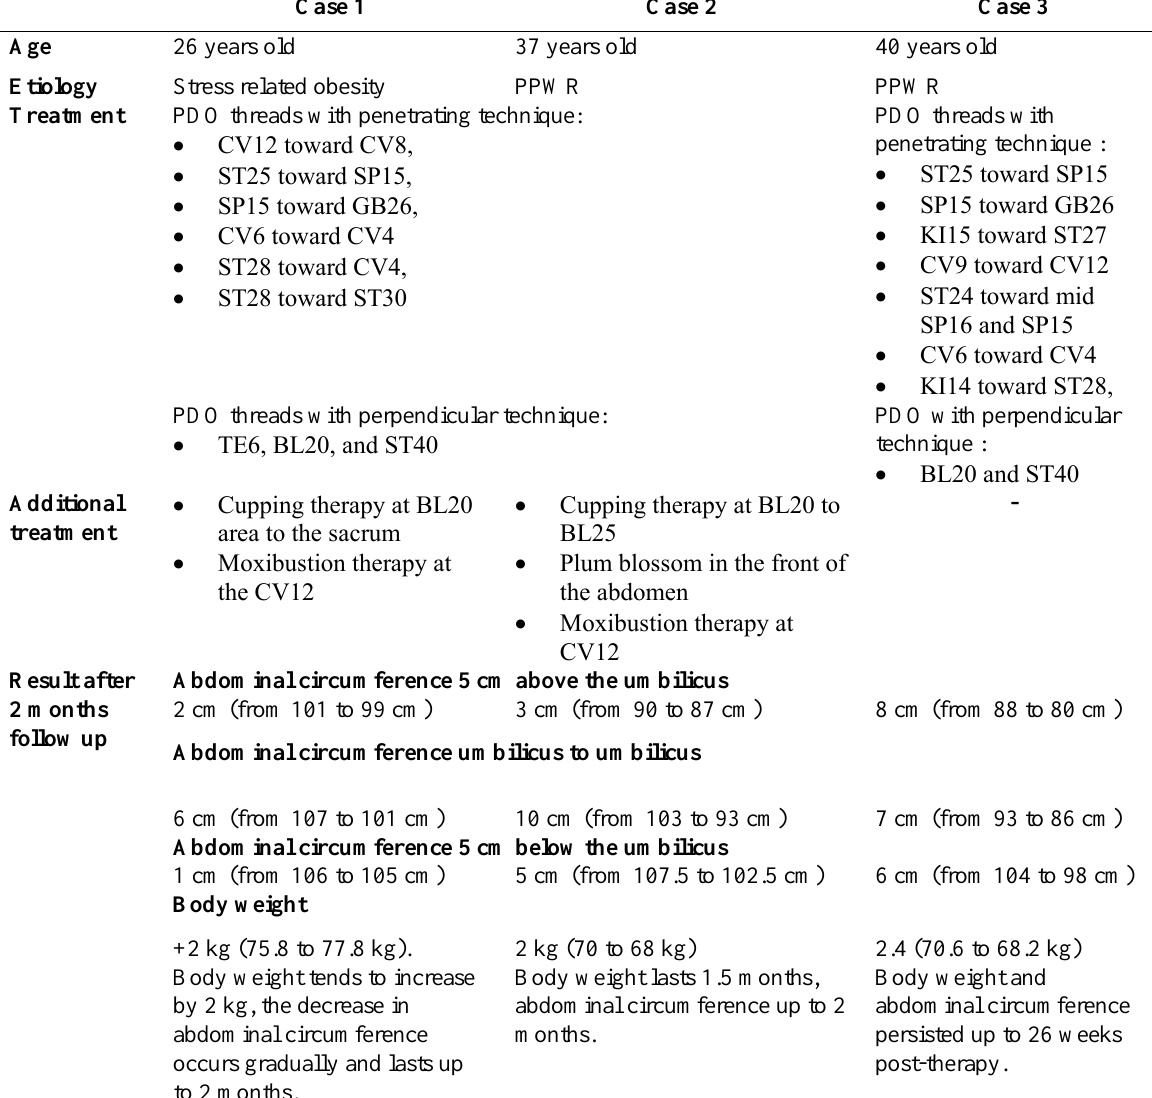
Table 1 Summary of the cases